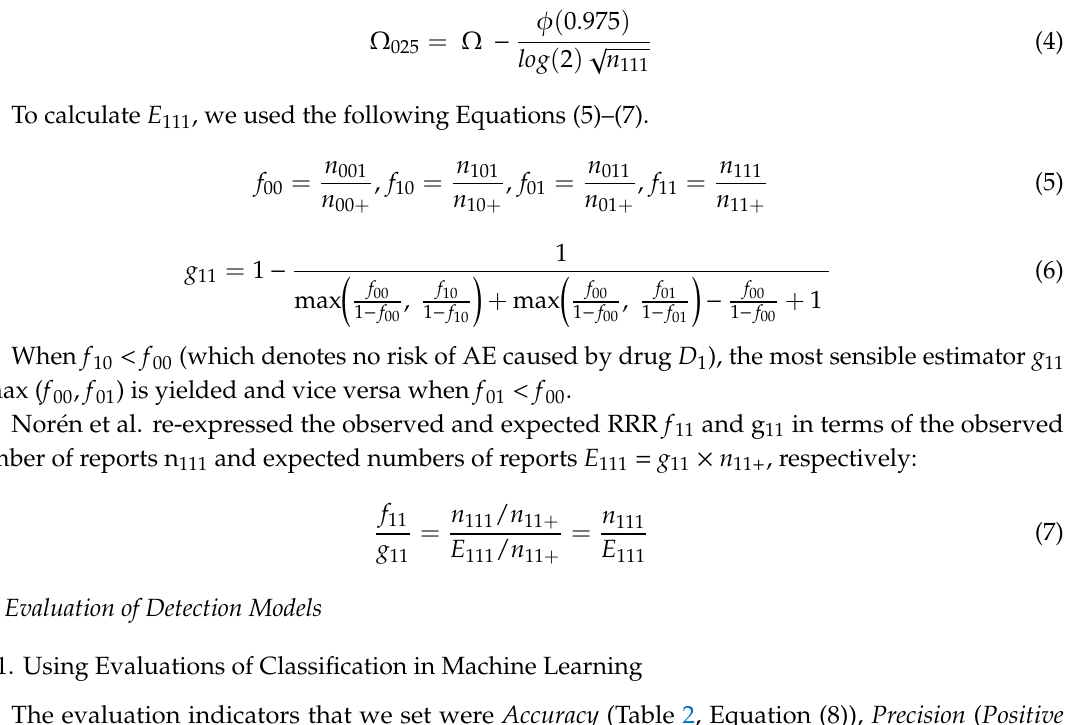
(Table 2, Equation (11)), Youden’s index (Table 2, Equation (12)), F -measure (Table 2, Equation (13)), and Negative predictive value ( NPV ) (Table 2, Equation